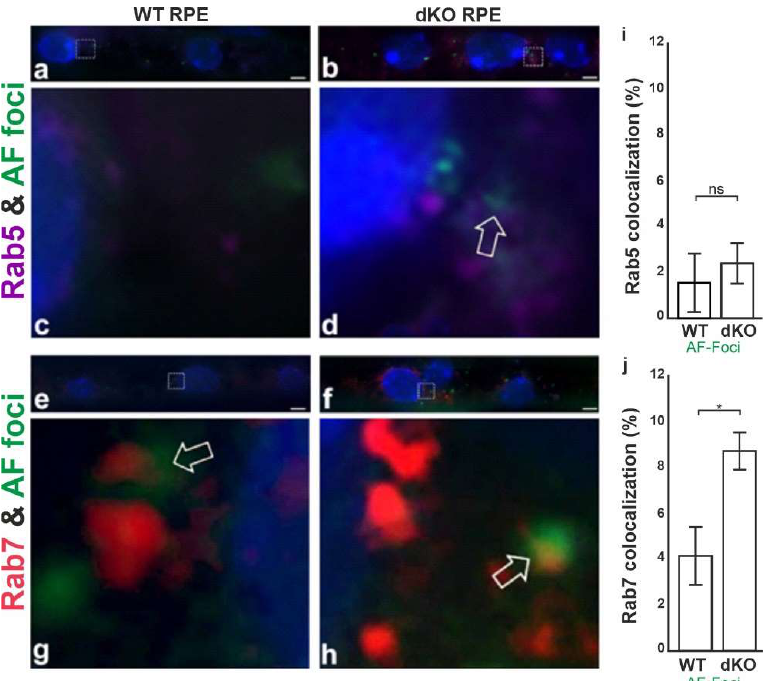
Figure 8. Representative high-power confocal microscopy images of WT ( a , c ; e , g ) and dKO ( b , d ; f , h ) show that Rab5 ( a – d ) and Rab7 ( e , f ) proteins are present throughout the cytoplasm of RPE cells but are prominently concentrated in the perinuclear space. However, they were differently expressed in WT and dKO RPE cells. Note that the formation of autofluorescence spots (AF) was more prominent in dKO samples ( c , g ), whereas WT RPE ( a , f ) exhibited only a few AF foci. The confocal plane and pinhole settings for the squared regions of WT and dKO were chosen to reveal mainly details of the pericellular space for Rab5, Rab7 and the distribution of AFs spots in WT and dKO samples, where the white arrow indicates the areas of possible colocalization. Quantification of Rab5 ( i ) and Rab7 ( j ) with AF foci colocalization. Colocalization analysis revealed a low association of early endosomal marker Rab5 with AF-foci in both genotypes studied, whereas the colocalization of the late endosomal marker Rab7 with AF-foci was clearly increased in dKO RPE compared to WT samples, mean ± SD. Scale = 1 µm. *p < 0.05. ns—Nonsignificant.